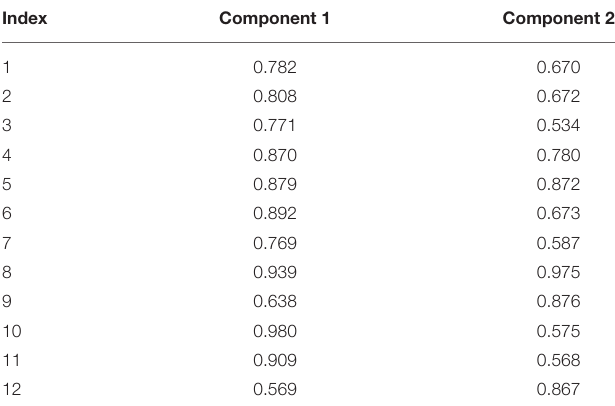
TABLE 2 | Rotational component